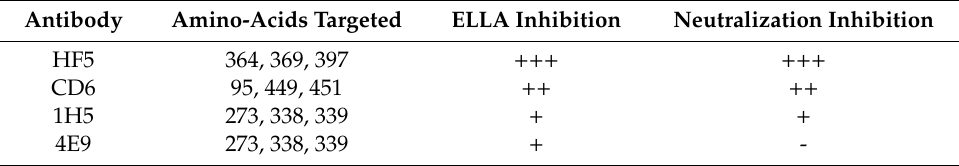
Table 1. NA antibody inhibition by epitope location. Antibody Amino-Acids Targeted ELLA